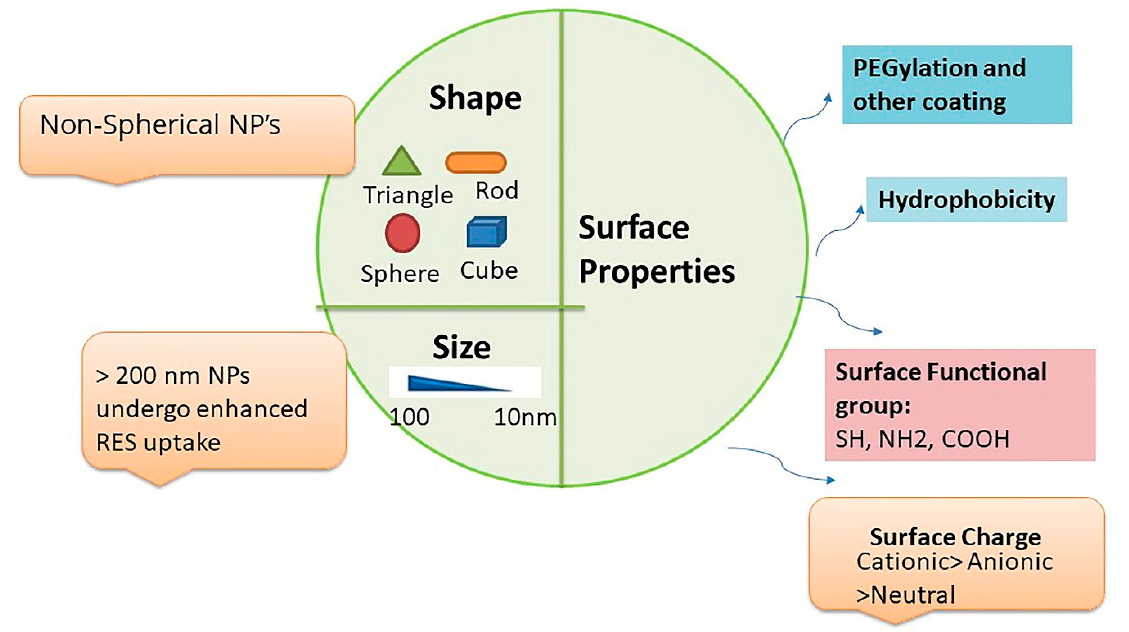
Figure 3. Physicochemical and surface properties of nanoparticles (NPs) that affect protein formation and reticuloendothelial system (RES) uptake. Particle size, shape, surface charge, lipophilicity, functional groups and polyethylene glycol (PEG)ylation influence the opsonization and RES uptake of NPs. Non-spherical shaped NPs of ≈ 100 nm undergo less RES uptake than spherical and larger-sized NPs. PEGylation, hydrophobicity, and slightly anionic or neutral zwitter ionic particles hinder protein corona formation and undergo less RES accumulation.